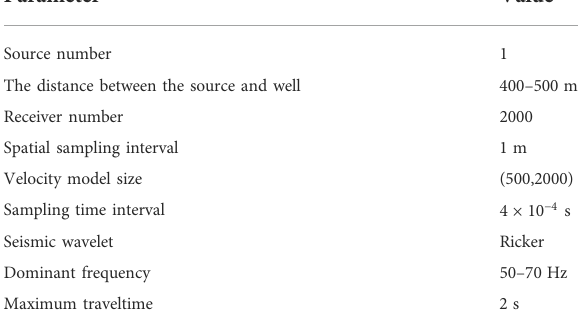
TABLE 1 The parameters of the forward